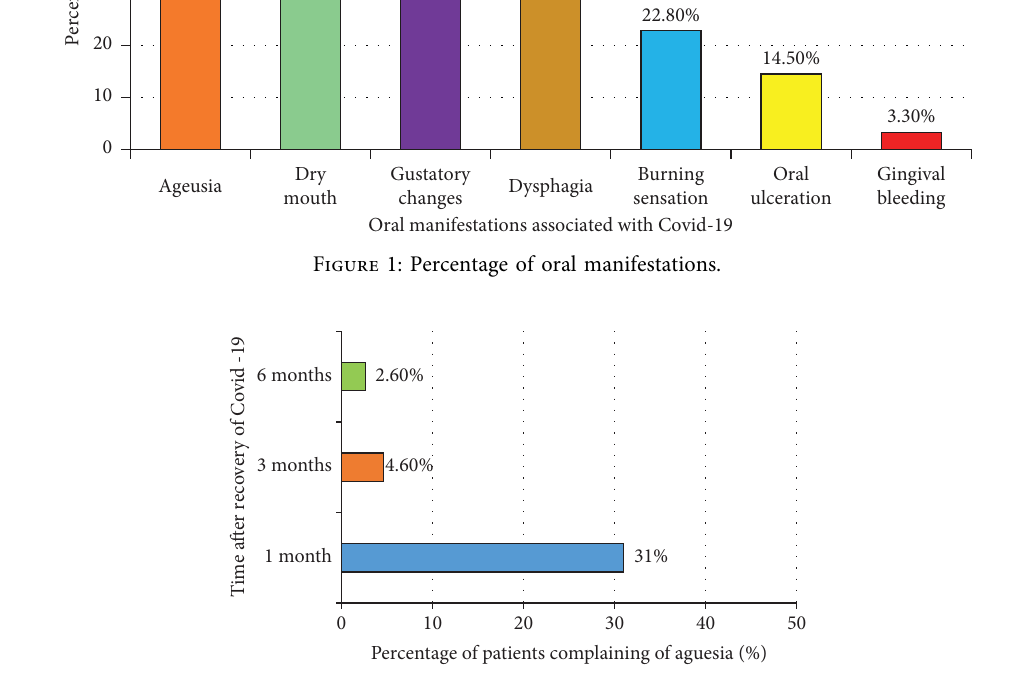
Figure 2: Percentage and duration of patients’ complaints from ageusia following infection.